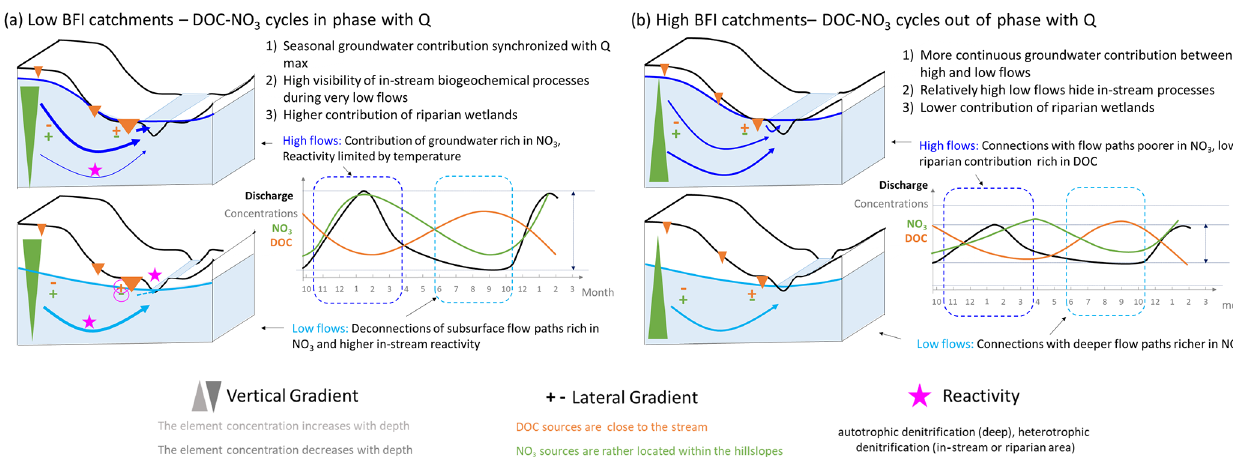
Figure 8. Conceptual diagram of seasonal flow paths involved in the DOC–NO 3 seasonal cycles leading to (a) in-phase cycles with discharge or (b) out-of-phase cycles with